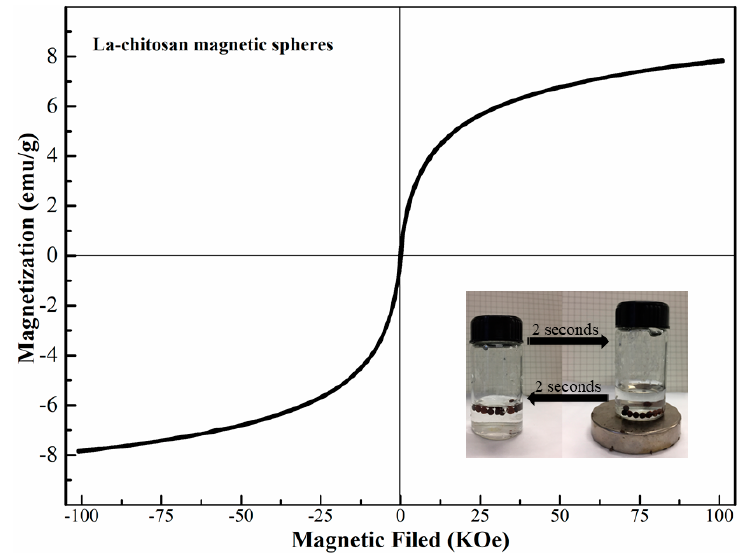
Figure 2. The magnetization curves of La-chitosan magnetic spheres (inserted with separation- redispersion process). redispersion